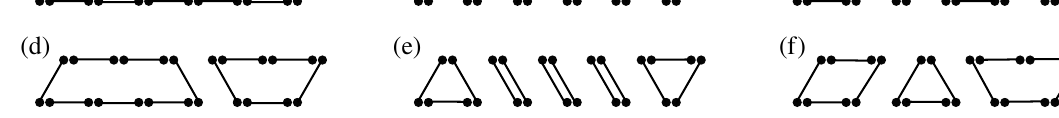
Figure 3: Sketches of quantum dimer ground state in (a) the NNN-Haldane; (b) the dimerized and (c) the trimerized phases. (d-f) examples of the other states that satisfy the quantum loop